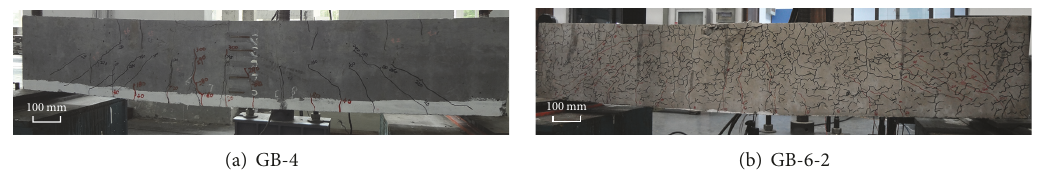
Figure 7: Failure of GC beams.